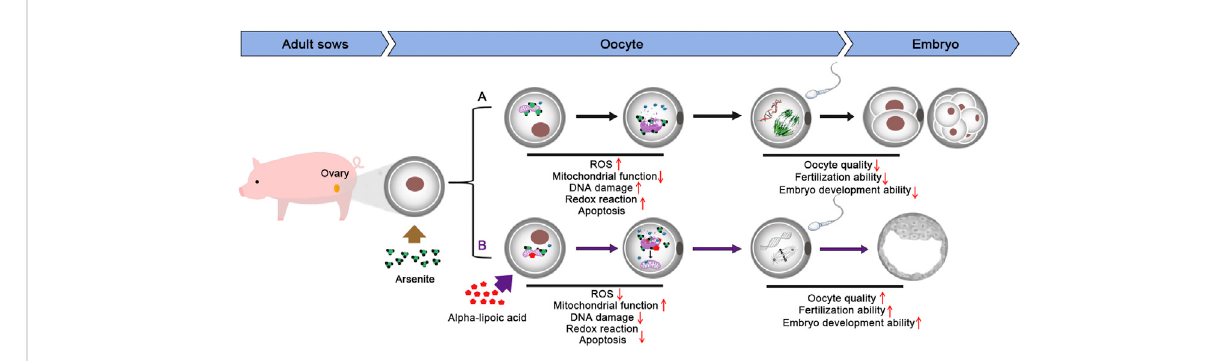
FIGURE 7 Diagram of the effects of ALA supplementation on arsenite-exposed